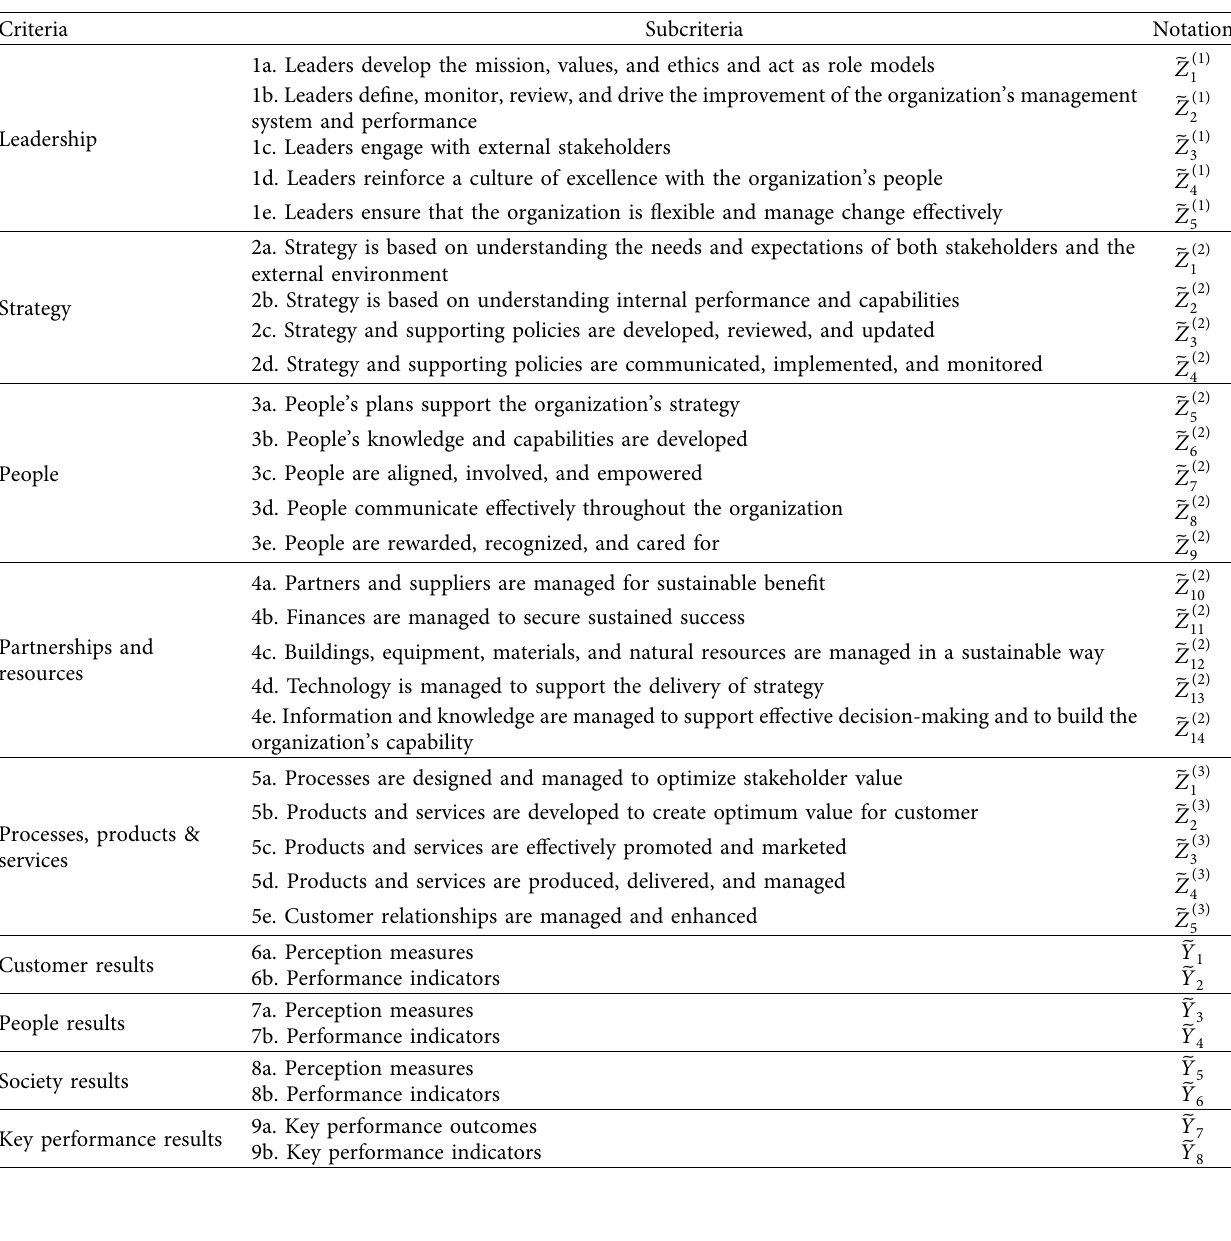
Table 2: Criteria and subcriteria in the EFQM excellence model.